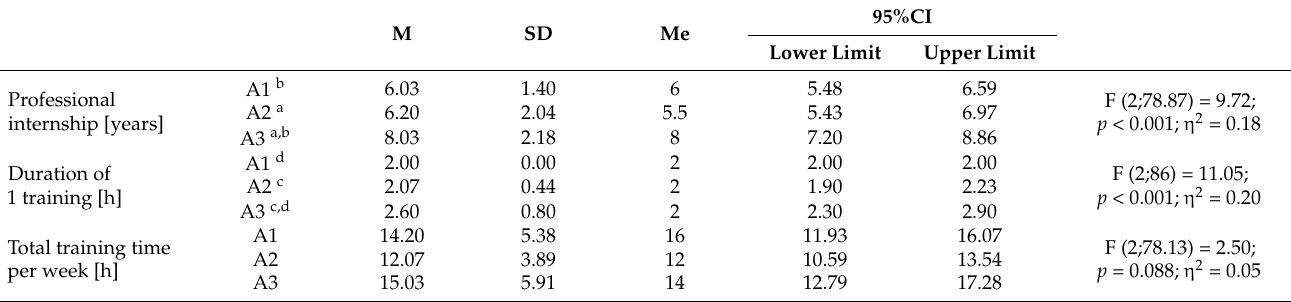
Table 2. Sports activity of groups of the study